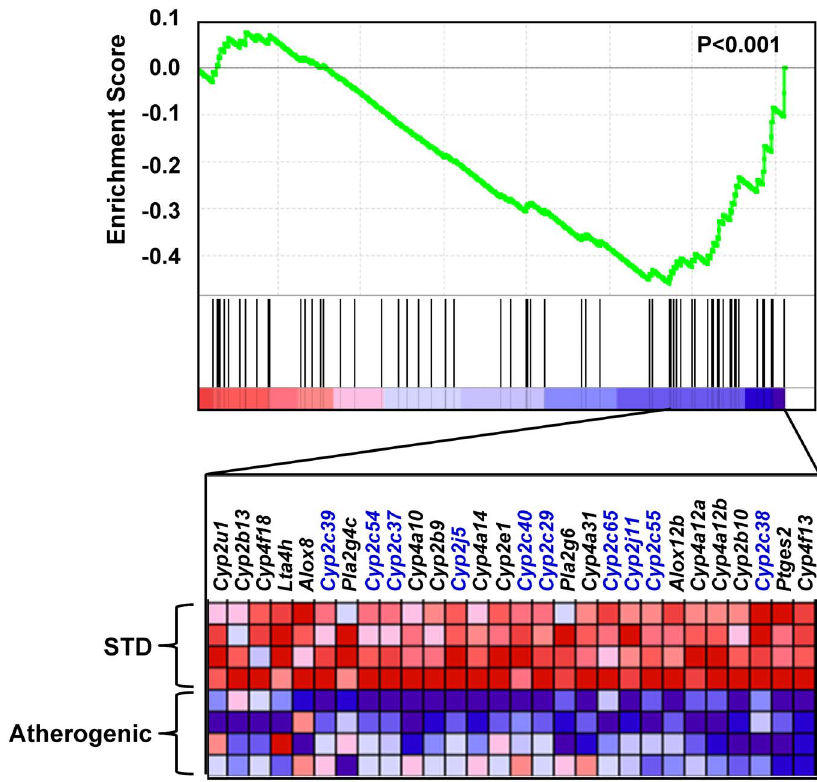
Figure 2. Hepatic expression of arachidonic acid metabolism pathway genes in response to atherogenic diet administration. Gene expression profiling was completed in liver using the Agilent Whole Mouse Genome Microarray (n=4 per group). To generate the enrichment plot, each gene on the microarray is rank-ordered (left to right) according to its correlation with atherogenic diet administration (most positive on the far left, most negative on the far right). The enrichment plot for the arachidonic acid metabolism pathway gene set enrichment analysis (GSEA) indicates the position of each gene (vertical lines) within the pathway in the overall rank-order of the correlation (top of figure). The p-value for the GSEA is provided. A heat-map is provided illustrating gene expression levels for each gene in the core enrichment subset (bottom of figure). Blue indicates the gene is down-regulated and red indicates the gene is up-regulated. CYP epoxygenase genes from the Cyp2c and Cyp2j subfamilies are denoted in blue.